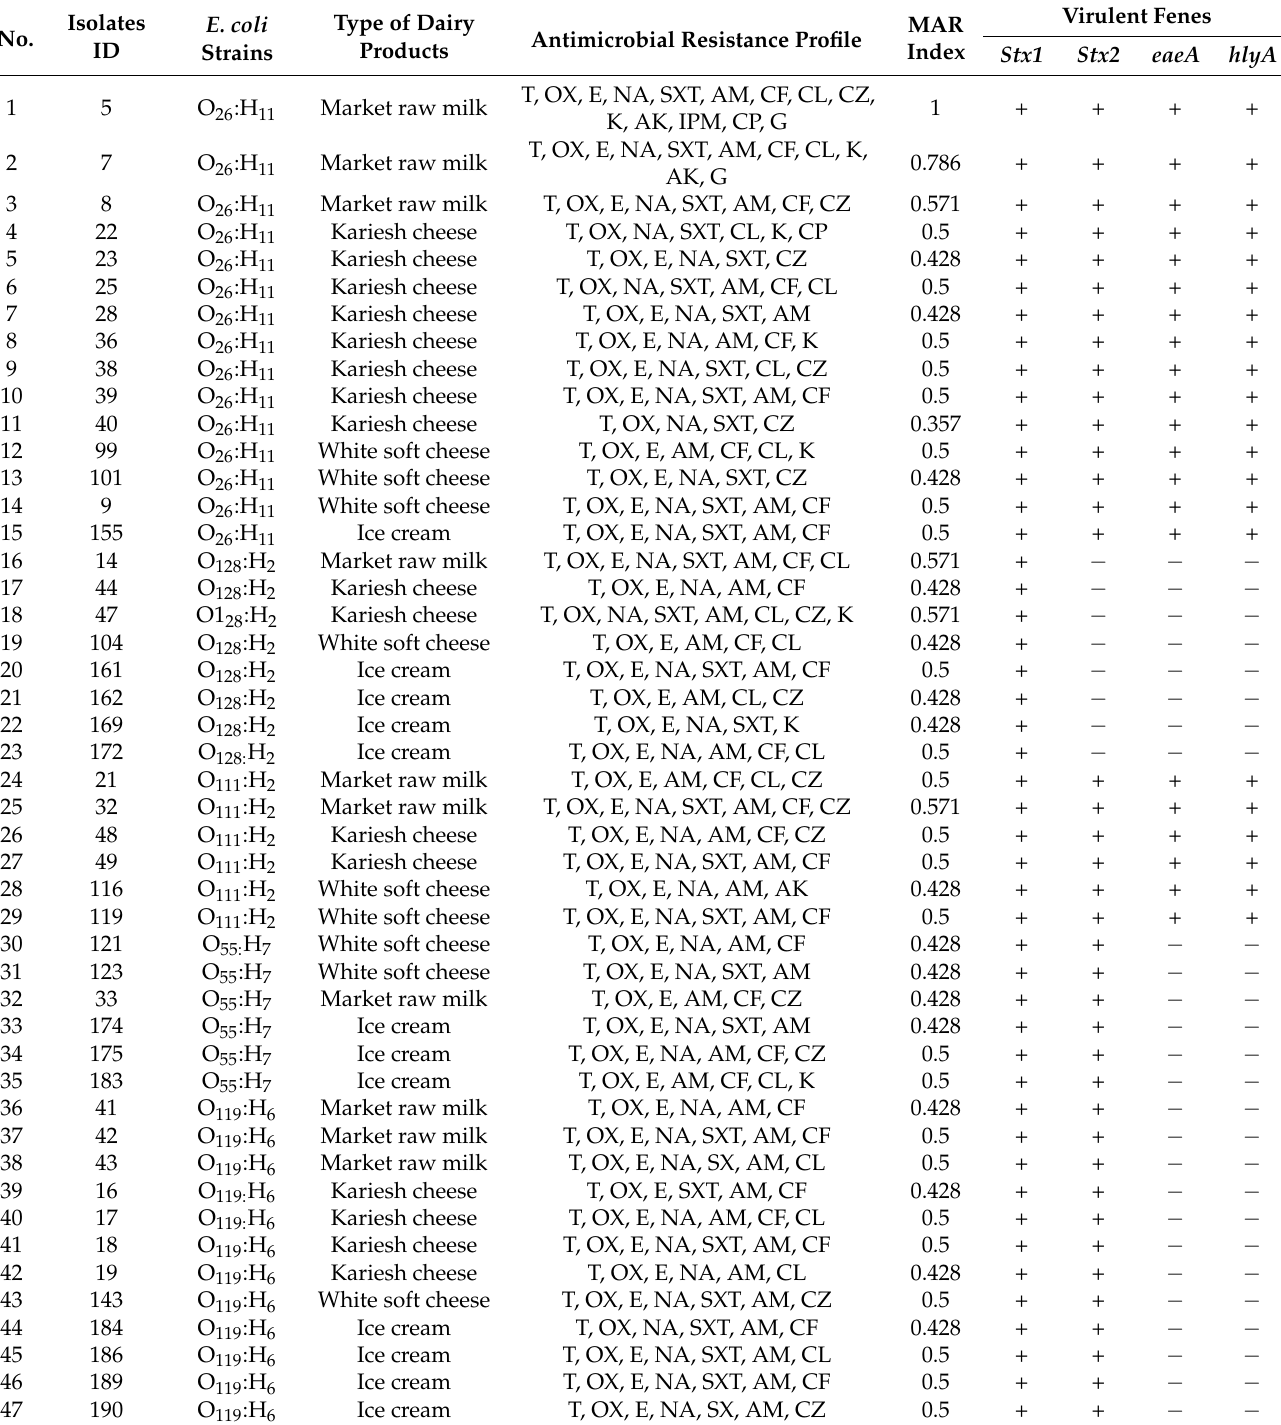
Table 4. Antimicrobial resistance profile and virulent genes of E. coli strains ( n =